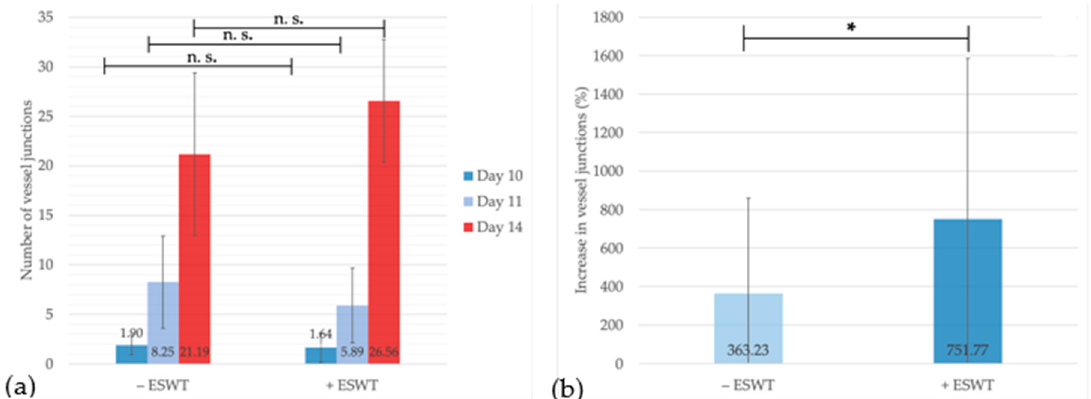
Figure 5. Vessel junction analysis within regions of interest over time. ( a ) Here, the number of vessel junctions between EDD-10 and EDD-14 is displayed. The number of junctions in treated and untreated groups was comparable until EDD-11. Four days post-treatment, the number of vessel junctions was slightly higher within the ESWT group compared to the control group. ( b ) The overall increase of junctions between EDD-11 and EDD-14 was significantly higher after ESWT. Shown are means ± SD, n.s. = not significant, * p < 0.1. ( a ) Independent-Samples T-Test between experimental groups and untreated control, normally distributed, homogeneity of variance. ( b ) Mann-Whitney test, not normally distributed.